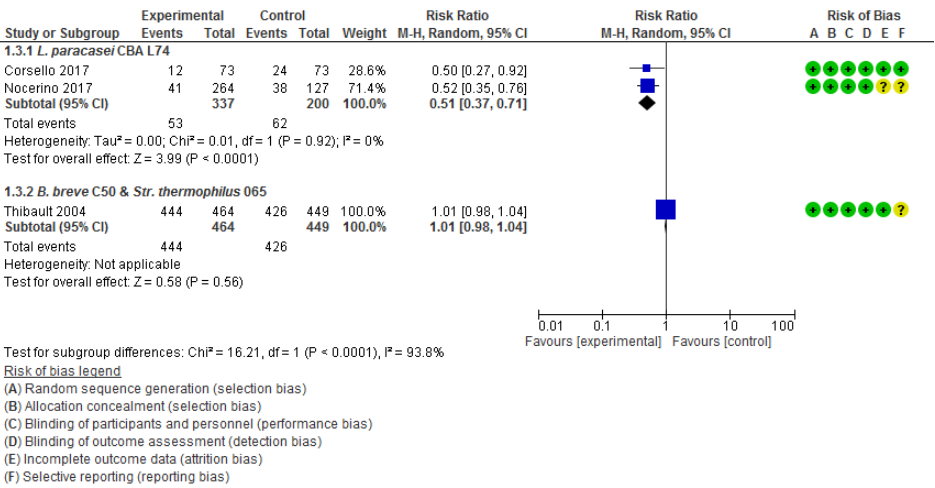
ff ect of postbiotic supplementation on preventing gastroenteritis. Figure 4. Effect of postbiotic supplementation on preventing gastroenteritis. Figure 4. E